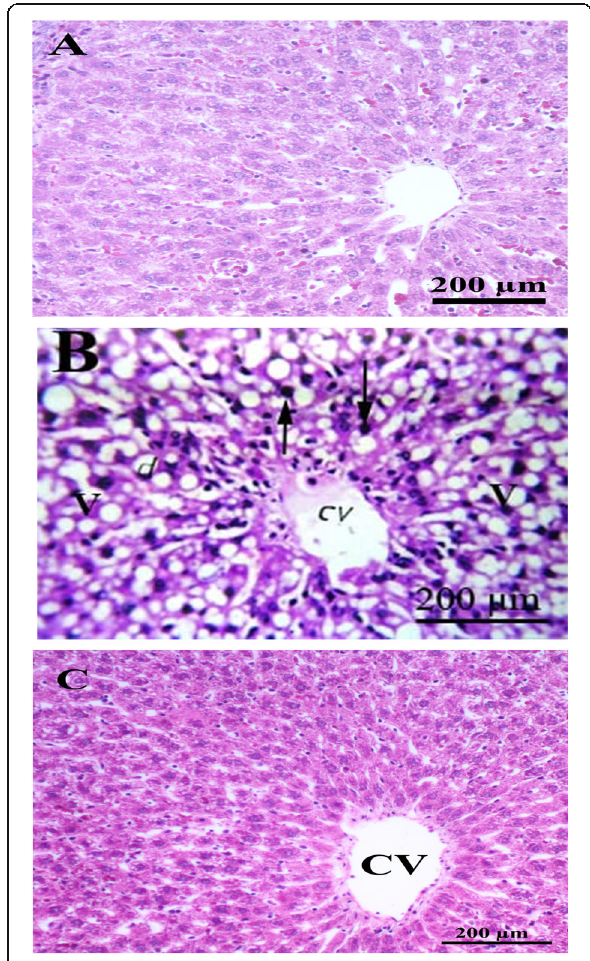
Fig. 11 a A transverse section of a liver of normal control (distilled water) rat showing a central vein, hepatic cords, and sinusoids in between, × 400. b A transverse section of a liver of dexamethasone group showing degenerative changes (d), vacuolation (V) all over the hepatocytes and pyknotic nuclei ( ↑ ), × 400. c A transverse section of a liver of dexamethasone and thyme group showing normal central vein (CV), hepatocytes with very little cell vacuolation, ×